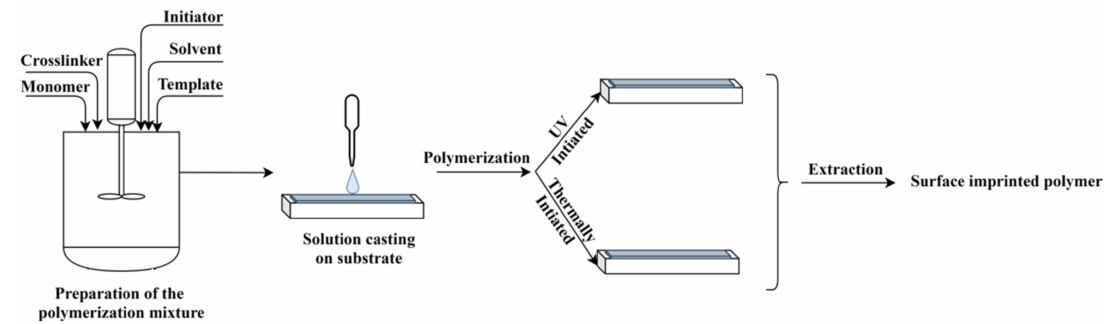
Figure 3. The principle of MIP layer preparation by surface polymerization.